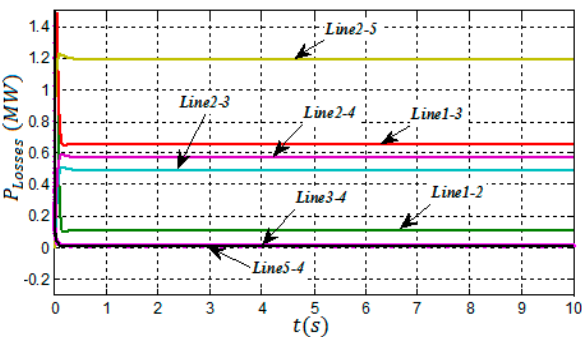
Figure 11. Active power losses in the lines before the integration of the wind farm.